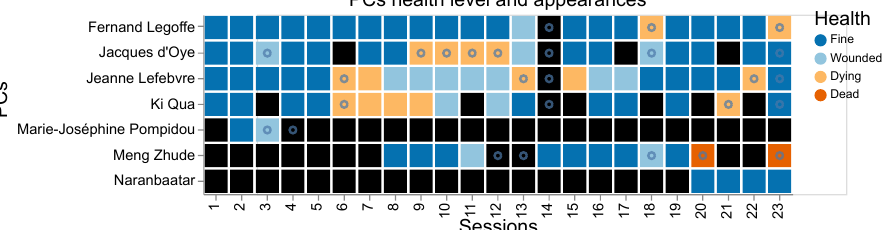
Figure 11. This visualization fostered various annotations that illustrate the extension of the classifi- cation